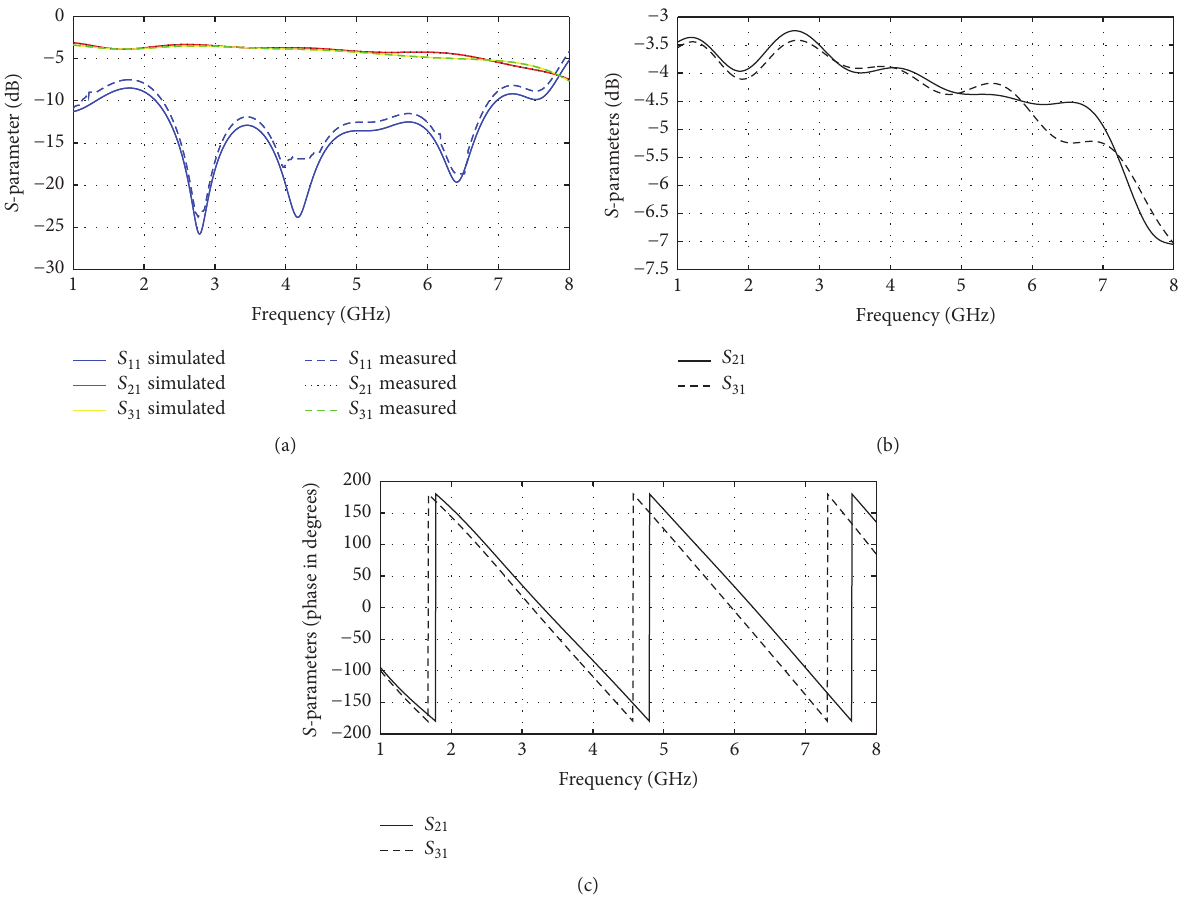
Figure 3: (a) Simulated and measured scattering parameters of power divider. (b) Magnitude of simulated 𝑆 21 and 𝑆 31 parameter. (c) Phase of simulated 𝑆 21 and 𝑆 31